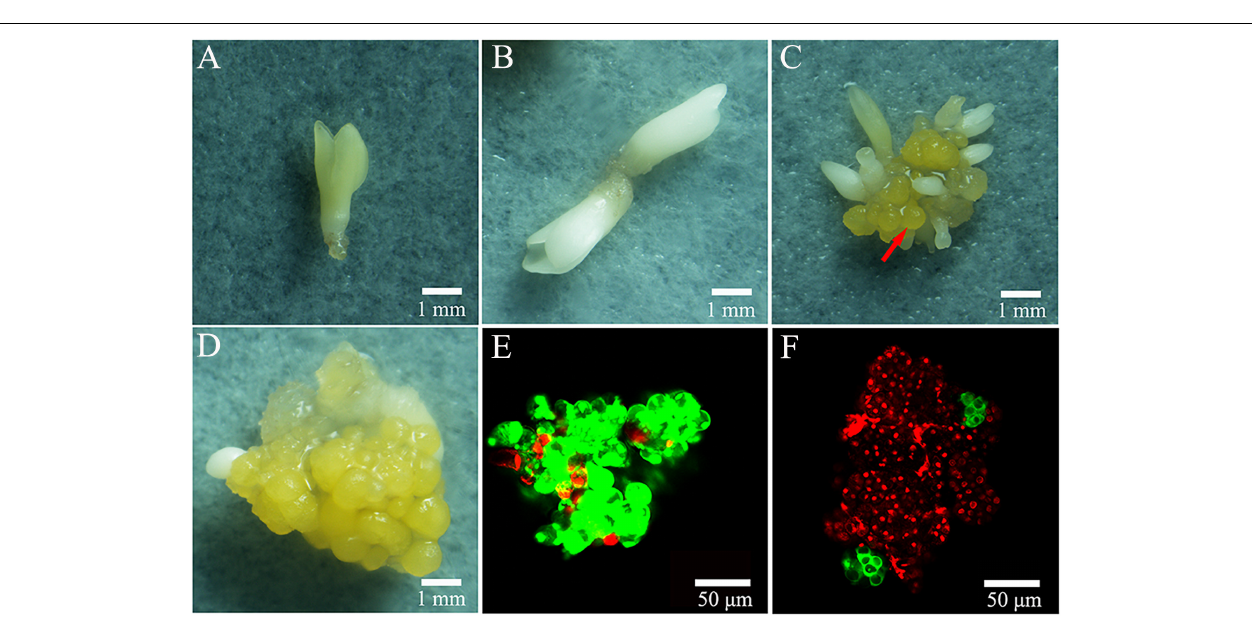
FIGURE 4 | Regeneration patterns of colchicine treated ECAs after 4 weeks regrowth culture. (A,B) Somatic embryo differentiation without new ECA formation. (C) New ECA (arrow) formation with many somatic embryos forming. (D) New ECA formation with scarce somatic embryo differentiation. (E) ECA double stained with FDA and PI. (F) Colchicine treated ECA (0.2% for 72 h) double stained with FDA and PI following 72 h regrowth culture.